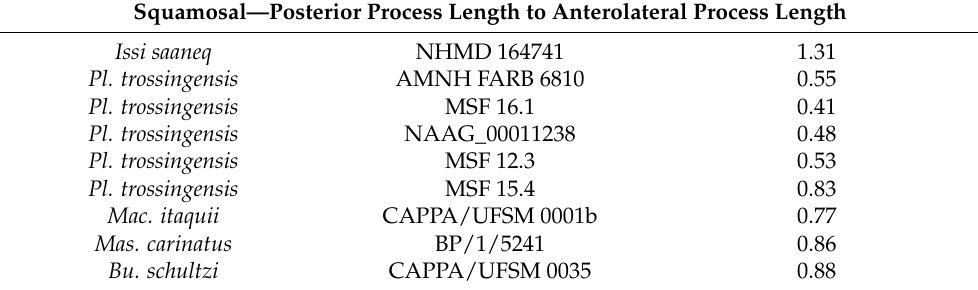
Table 3. Relative length of the posterior to the anterolateral processes of the squamosal across basal sauropodomorphs. Measurements were taken on the 3D models when